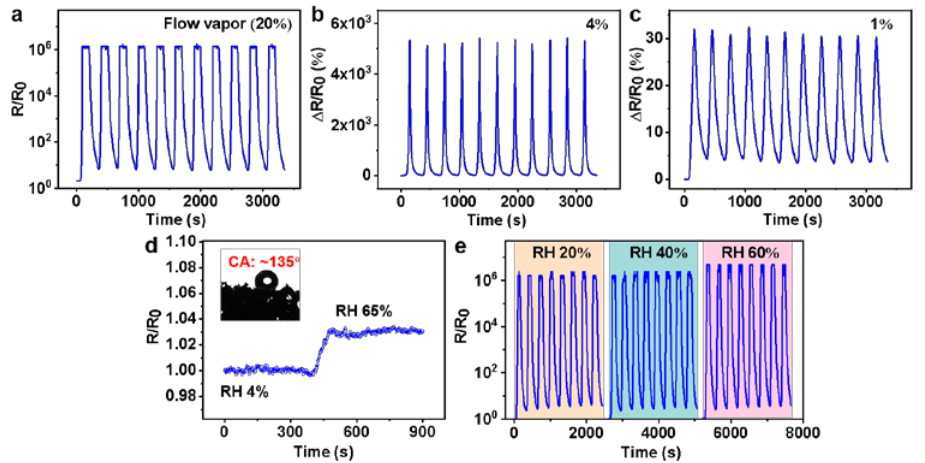
Figure 5. ( a ) Cyclic vapor-sensing behavior of CPS to flowing, saturated n-hexane vapor. ( b , c ) Cyclic vapor-sensing behavior of CPS upon exposure to flowing n-hexane vapor with low concentrations of 4% and 1%, respectively. ( d ) The real-time electrical resistance change of CPS under different RH environments at 25 °C. The inset shows test result of the water contact angle. ( e ) The real-time responsivity of CPS to flowing, saturated n-hexane vapor under different RH environments at 25 °C.